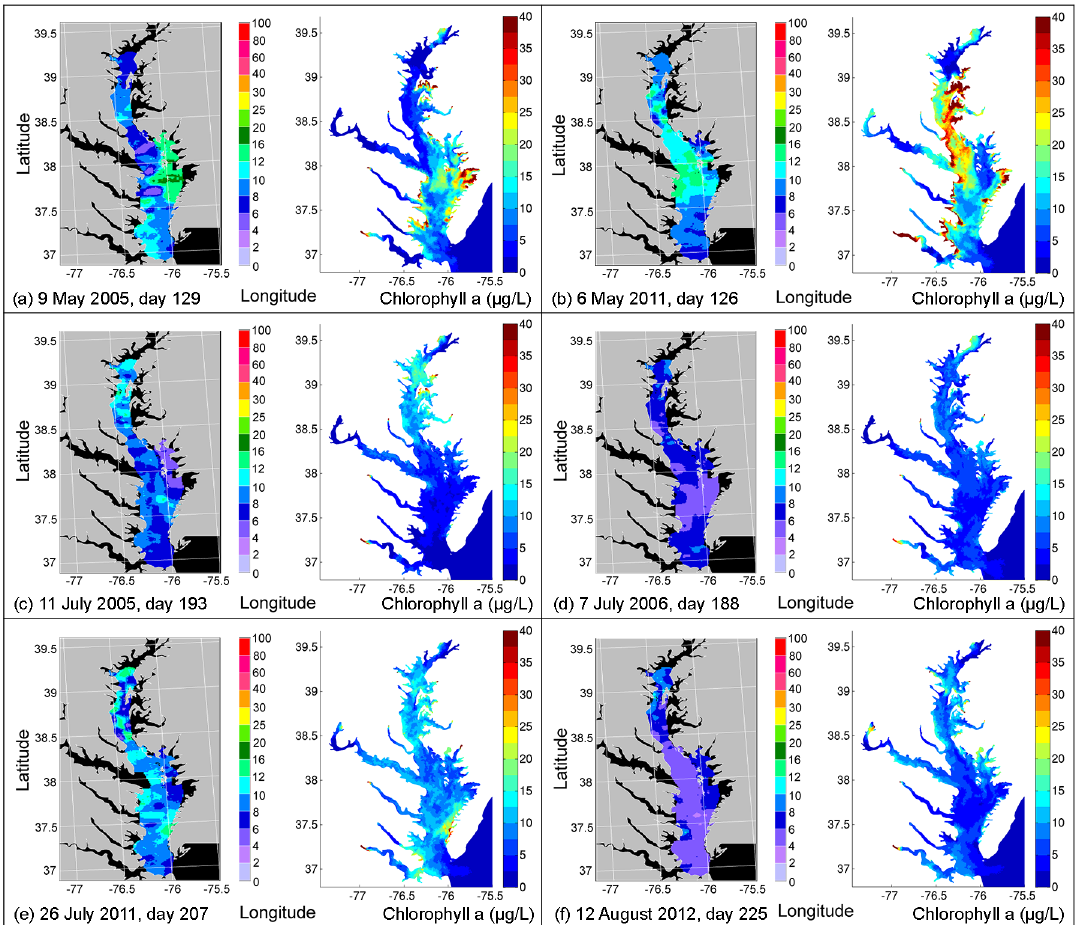
Figure 14. Remote sensing and simulated surface chlorophyll ‐ a of Chesapeake Bay on: ( a ) 9 May 2005; ( b ) 6 May 2011; ( c ) 11 July 2005; ( d ) 7 July 2006; ( e ) 26 July 2011; and ( f ) 12 August 2012. Remote sensing data source: Chesapeake Bay Remote Sensing Program.